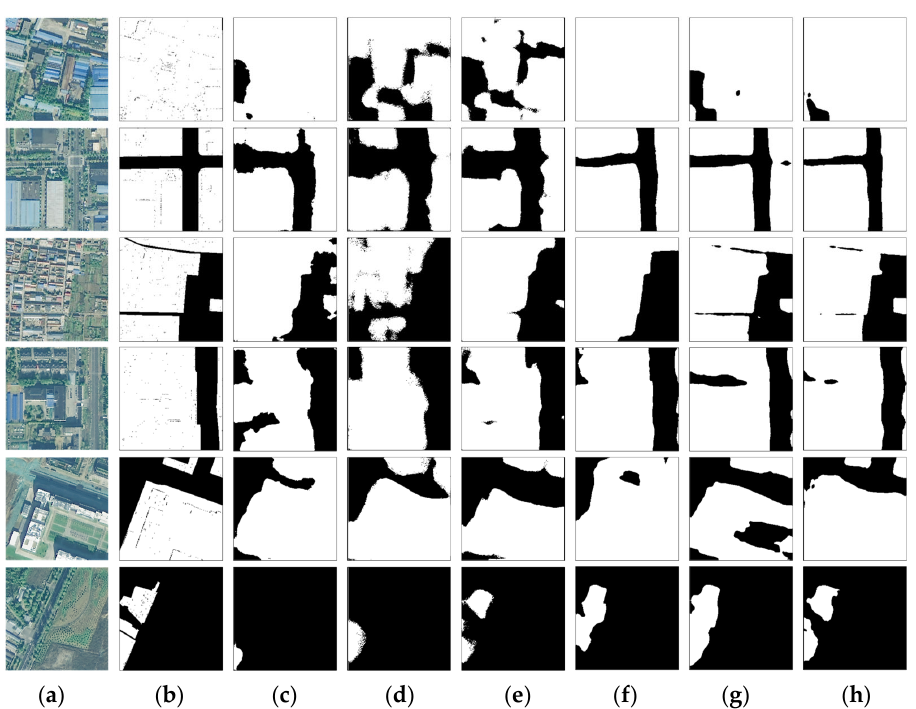
Figure 11. Segmentation results obtained by different image color translation methods on the Beijing Huairou district land survey dataset, ( a ) 2019 image, ( b ) 2019 ground truth, ( c ) baseline, ( d ) HM, ( e ) Reinhard method, ( f ) DRIT, ( g ) UNIT, and ( h ) CycleGAN. Table 3. Evaluation metrics of the results obtained by different semantic segmentation methods on the Wuhan University building change detection dataset.